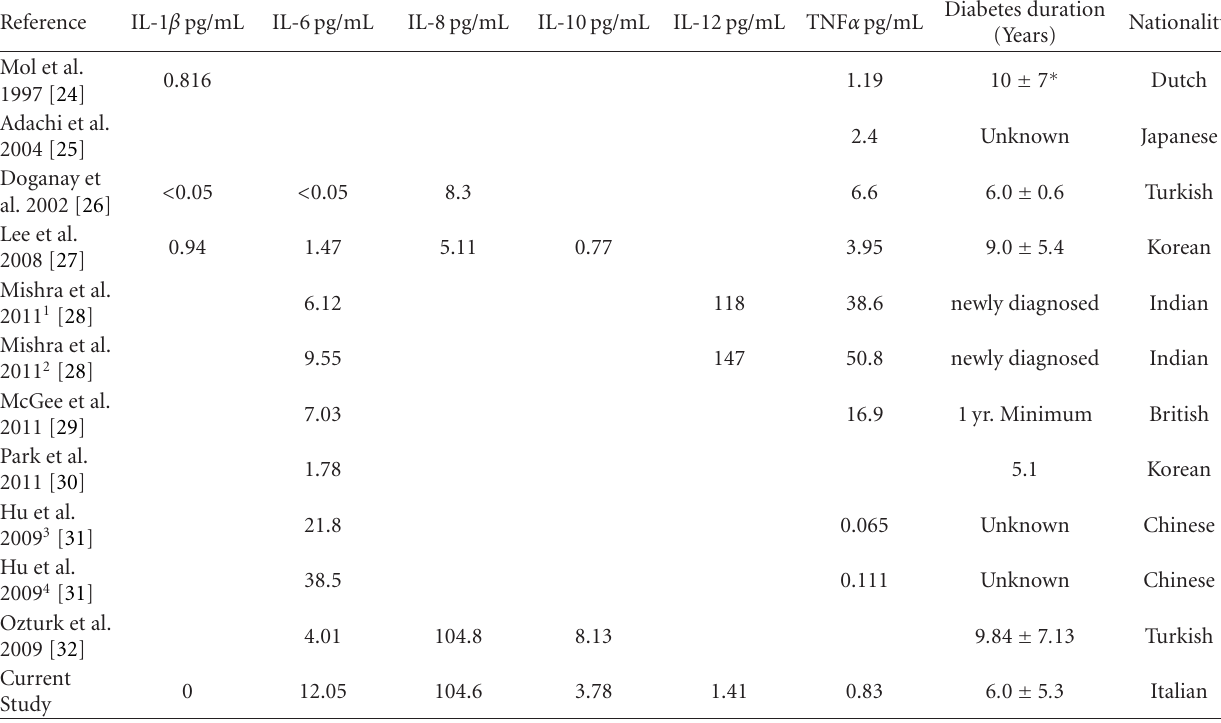
Table 3: Summary of serum cytokine values reported from recent